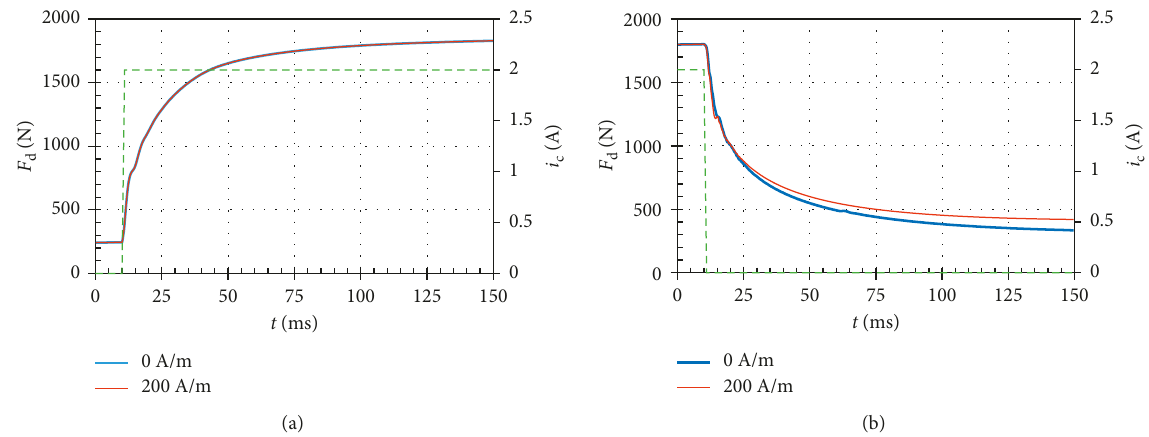
Figure 20: Force time history: damper response to current step input, I line). (a) Current rise. (b) Current drop.